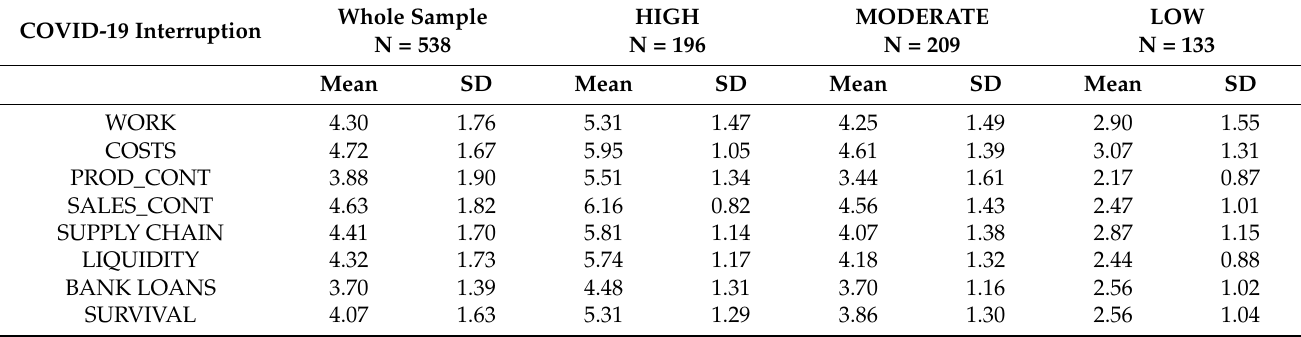
Table 4. Results of k-means clustering: clusters of high, moderate and low COVID-19 interruptions.